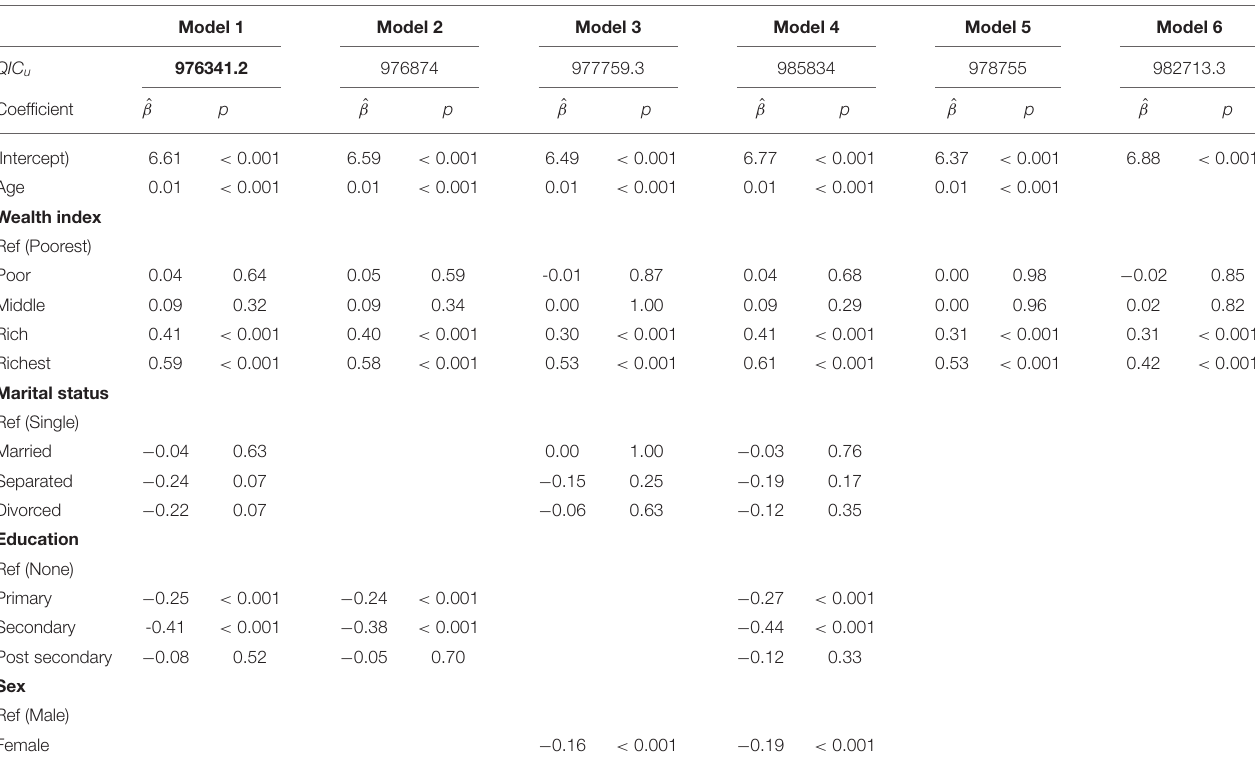
TABLE 4 | Different model outputs with calculated QIC u